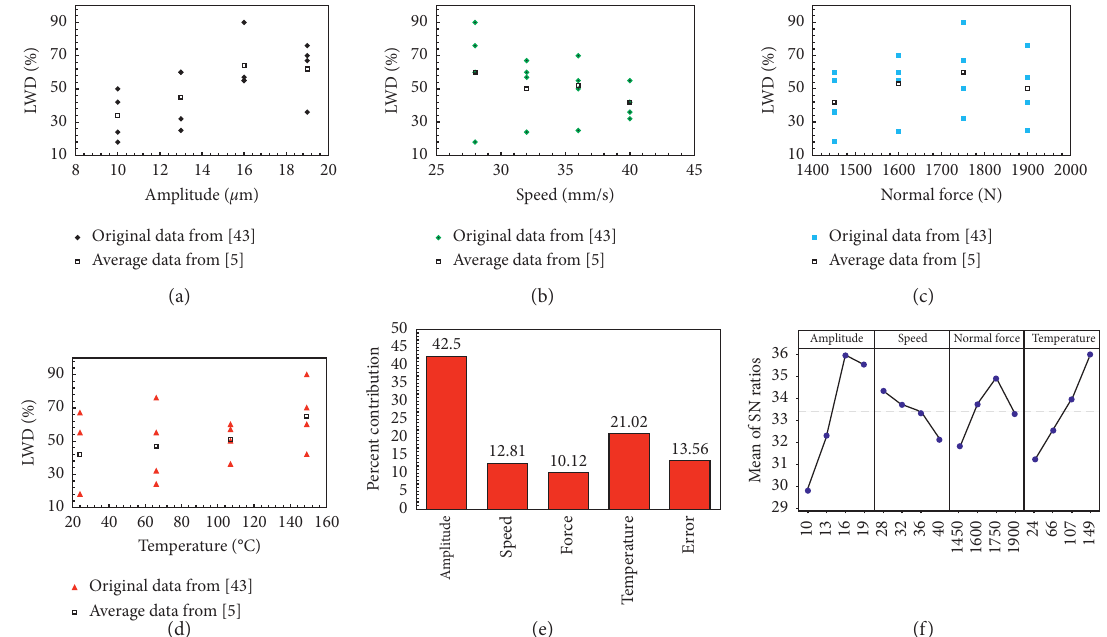
Figure 4: Effect of (a) amplitude, (b) speed, (c) normal force, and (d) substrate temperature on % LWD of Al3003 build material. ((a–d) redrawn from [43], (e) and (f) from this work).